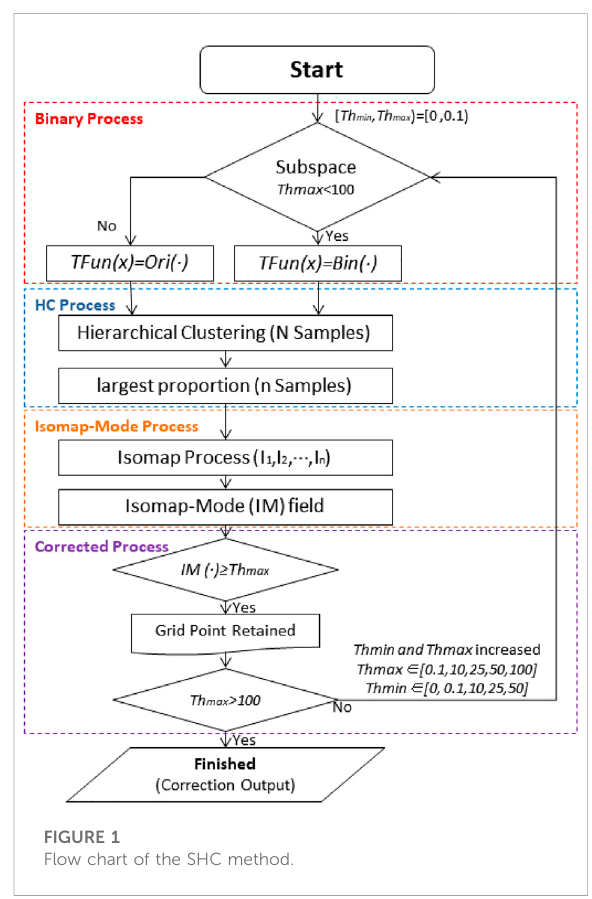
FIGURE 1 Flow chart of the SHC